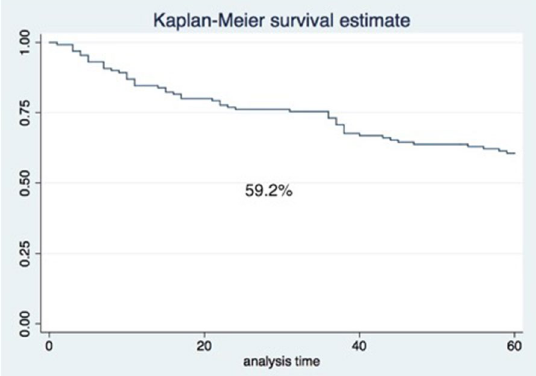
Fig. 1 Kaplan-Miere curve of disease-free survival (5 years) of oral tongue squamous cell carcinoma. Disease-free survival of 59.2% at 5